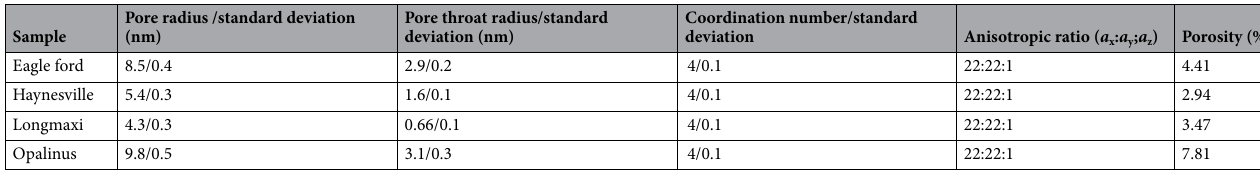
Table 1. Shale sample parameters 23, 24